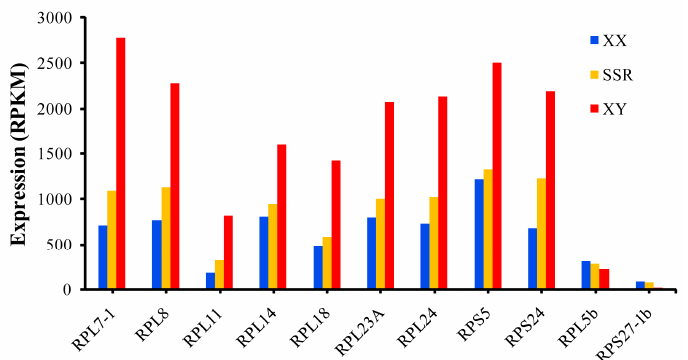
Figure 8. Sexually dimorphic expression of RP genes in XX and XY gonads based on gonadal transcriptome data from normal and secondary sex-reversal (SSR) tilapia [31]. SSR tilapia were obtained by feeding XX fish a diet sprayed with 95% ethanol containing Fadrozole at a concentration of 200 µ g / g diet from 90 to 180 dah. The control XX and XY fish were fed a diet sprayed with 95% ethanol but without Fadrozole. RNA preparations from gonads of XX, XY and sex-reversed individuals at 180 dah were sequenced using Illumina 2000 HiSeq technology in our previous study. RPKM (reads per kb per million reads) was used to normalize the expression profiles of RP genes.